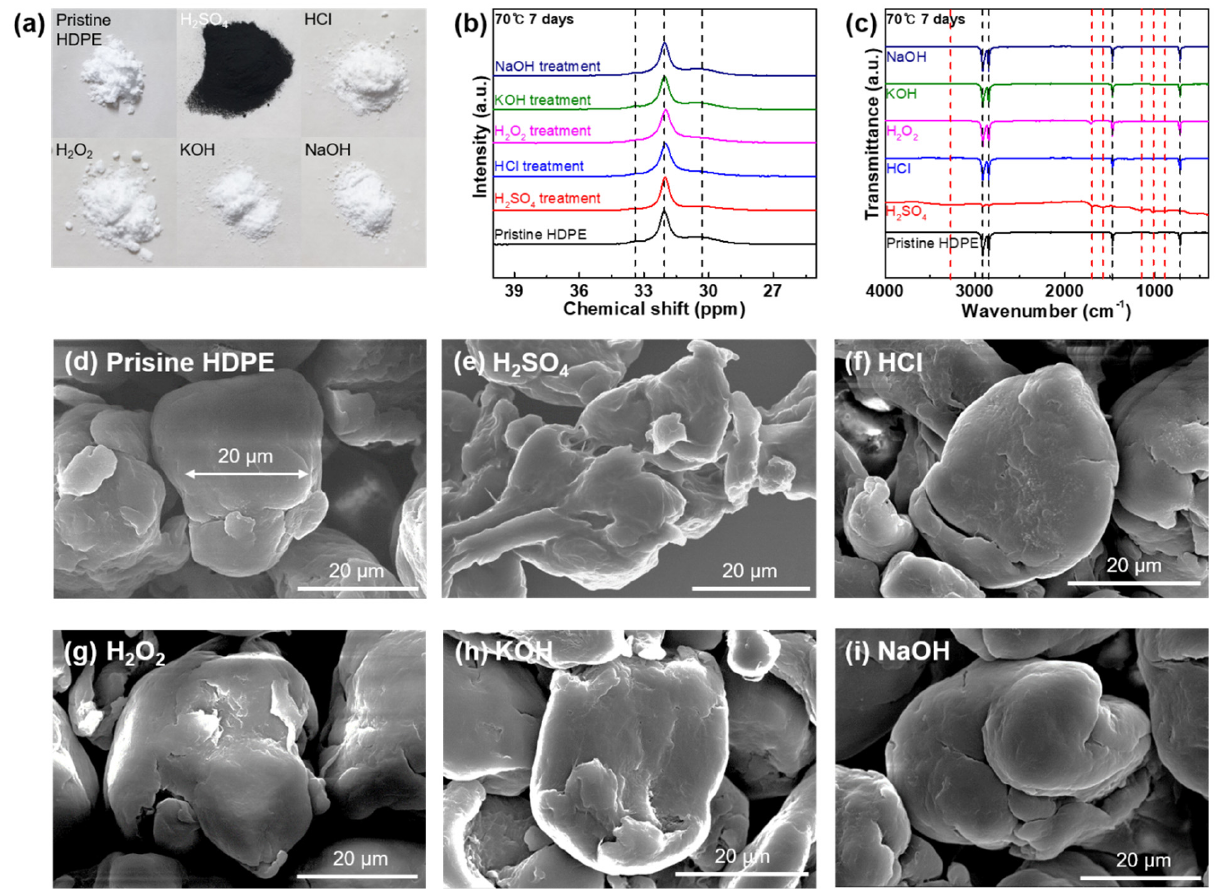
Figure 2. ( a ) Photograph of the HDPE samples in the pristine state and after chemical stability tests against strong acids, bases, and oxidizing agents (H 2 SO 4 , HCl, H 2 O 2 , KOH, and NaOH) used in